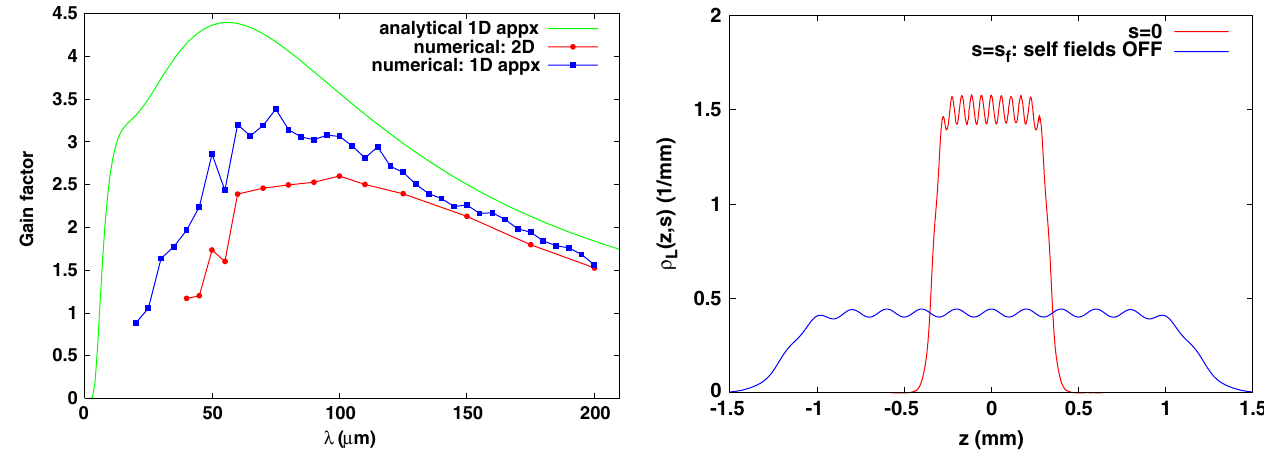
FIG. 21. Left: Analytical gain factor (green line) and numerical gain factor computed with the 2D model with the TFCT method (red line) and the 1D field approximation scheme with the TWT method (blue line). We notice that the 1D and 2D numerical results differ at short wavelengths from the analytical formula and agree quite well with each other, showing a decrease of the gain factor for the range (cid:8) (cid:5) 70 – 100 (cid:9) m . The derivation of the analytical gain factor formula is based on a linearized Vlasov treatment with a steady state CSR wake, therefore we do not expect close agreement with our numerical simulations. Right: Longitudinal density for (cid:8) ¼ 200 (cid:9) m without self-fields showing at s ¼ 0 and s ¼ s f